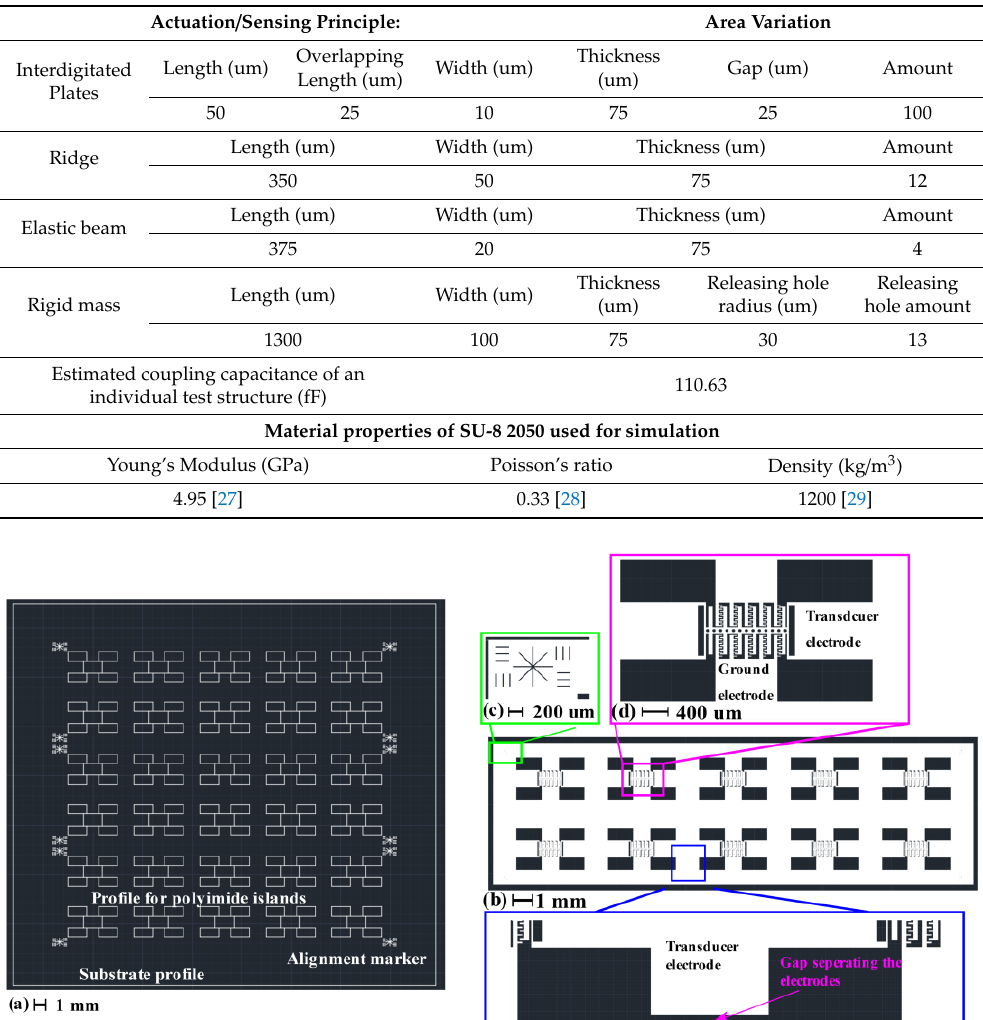
Table 2. Structural parameters of the in-plane SU-8 MEMS test structures.